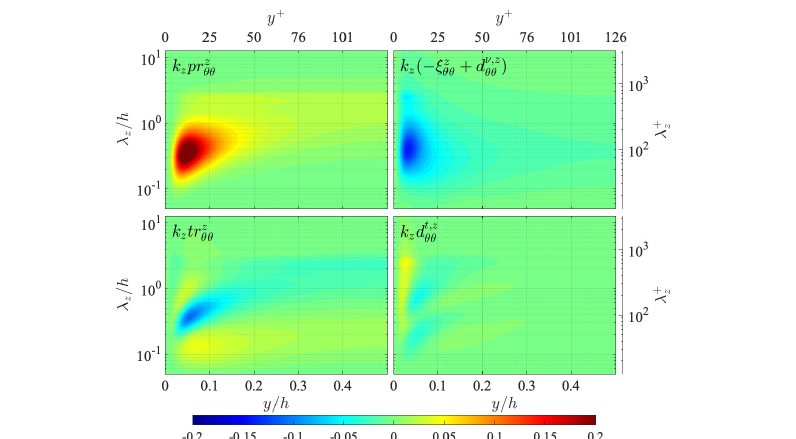
Figure 10. Space-wavelength ( y − λ z ) diagrams of terms in the transport equation of the tem- perature fluctuation spectrum E z ( bottom left ) interscale transport tr z in the premultiplied form, and the values are scaled by u 2 τ T 2 τ / ν